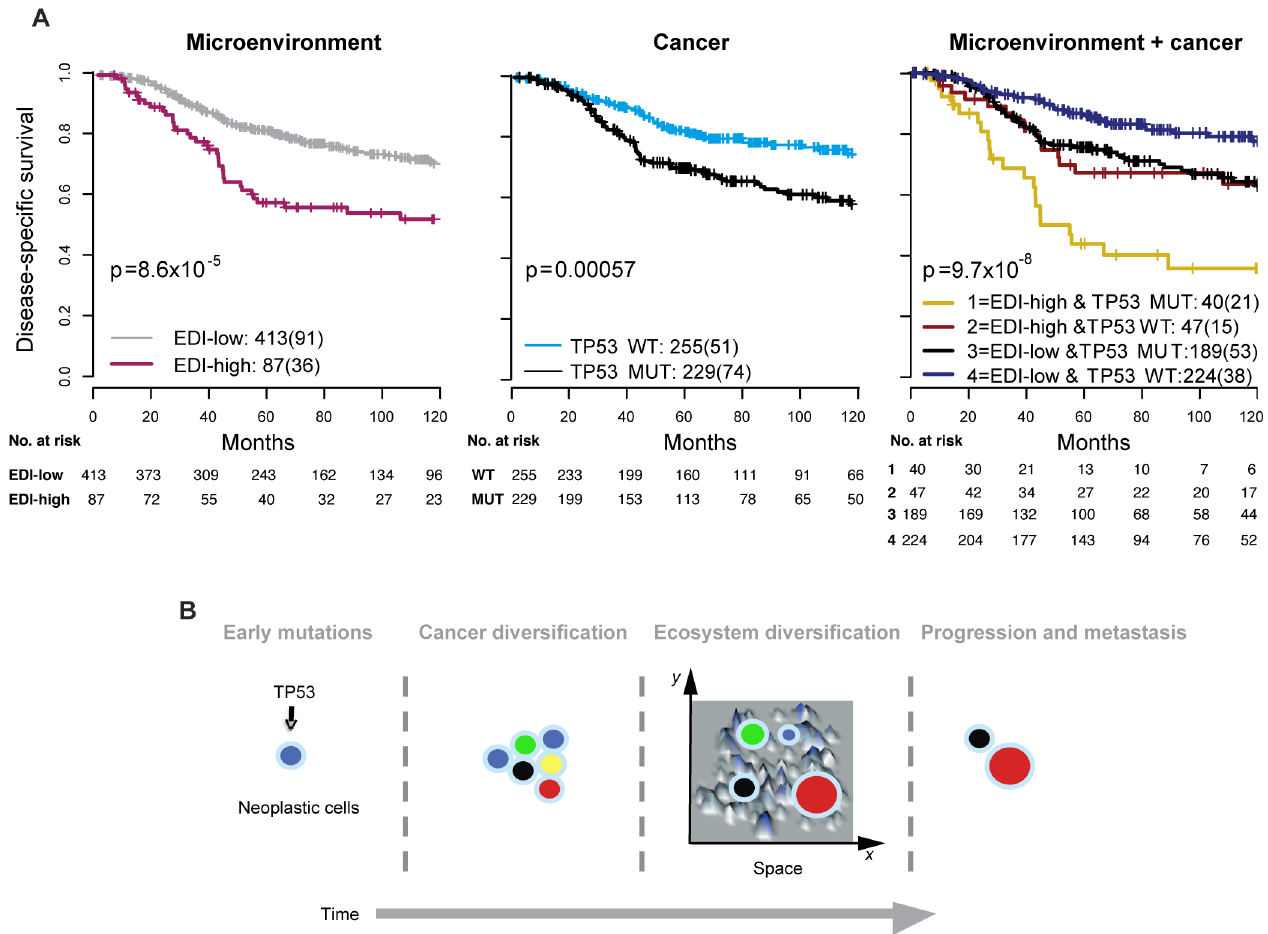
Fig 4. Accumulated prognostic value of microenvironmental heterogeneity and cancer TP53 mutation in high-grade breast tumors. (A) Kaplan – Meier curves illustrating the duration of disease-specific survival according to microenvironmental heterogeneity (EDI, left panel), TP53 mutation (middle panel), and both (right panel) in 507 grade 3 breast tumors. MUT, mutant; WT, wild-type. (B) Schematic diagram to illustrate the hypothesized temporal progression of invasive breast cancer with loss of TP53 tumor suppressor functions as an early-stage event and spatial diversification of microenvironment as late-stage